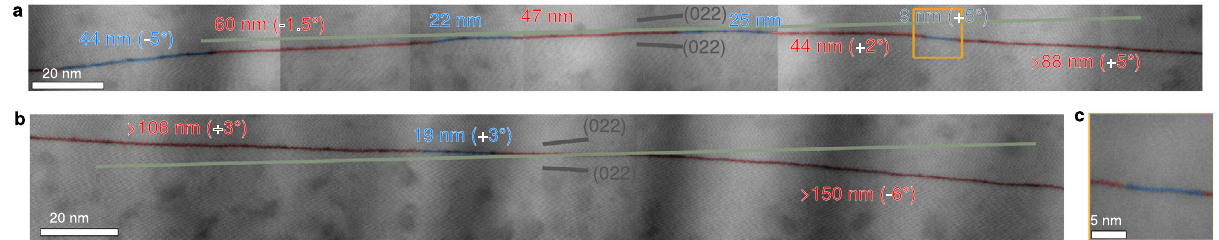
Fig. 2 Overviews of two, more than 300 nm long, GB segments assembled from multiple HAADF-STEM images of near-symmetric areas of a Σ 37c 〈 111 〉 GB. a , b The GBs consist of multiple, alternating domino (red) and pearl (blue) segments. The lengths of each segment are indicated as well as the deviation off the symmetric GB plane (green line). c Magni fi ed view of the orange region in ( a ). The domino segments in symmetric areas (<5° off the symmetric case) are between 40 and 60 nm long, whereas the pearl segments are shorter with 10 – 40 nm. A high-resultion version of this image can be found in Supplementary Fig. 2.